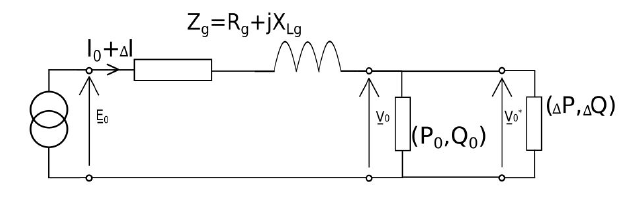
Figure 1. Grid equivalent